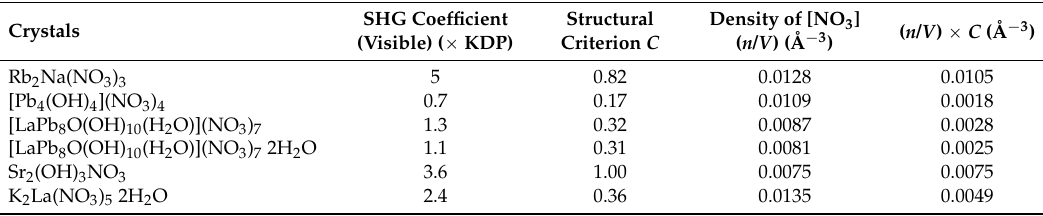
Nonlinear optical (NLO) effects of Rb 2 Na(NO 3 ) 3